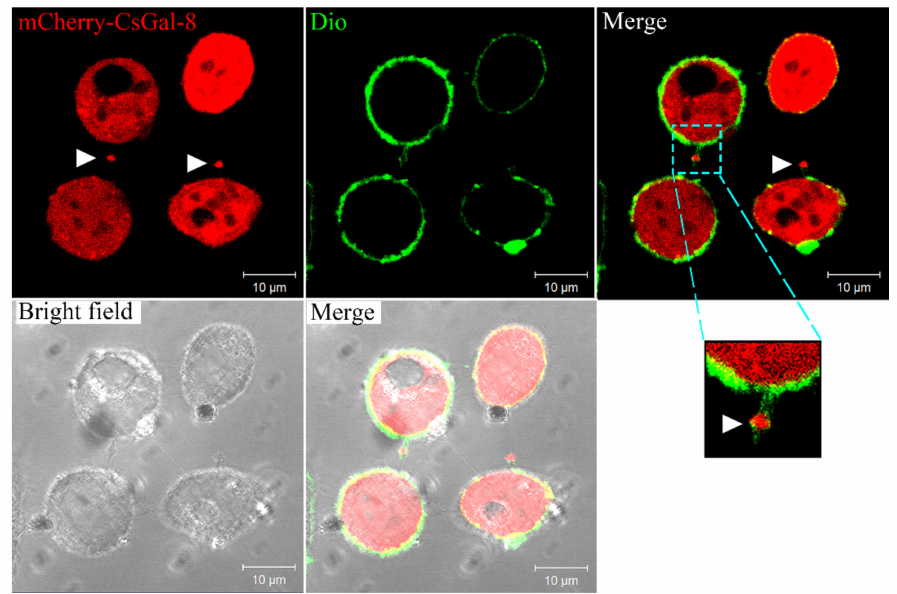
Figure 3. Intracellular distribution of CsGal-8. mCherry-tagged CsGal-8 was expressed in HeLa cells and observed with a confocal microscope. mCherry-tagged CsGal-8 was in red color and cell membrane was in green color after staining with DiO. Extracellular vesicles containing mCherry-tagged CsGal-8 are indicated by arrowheads.